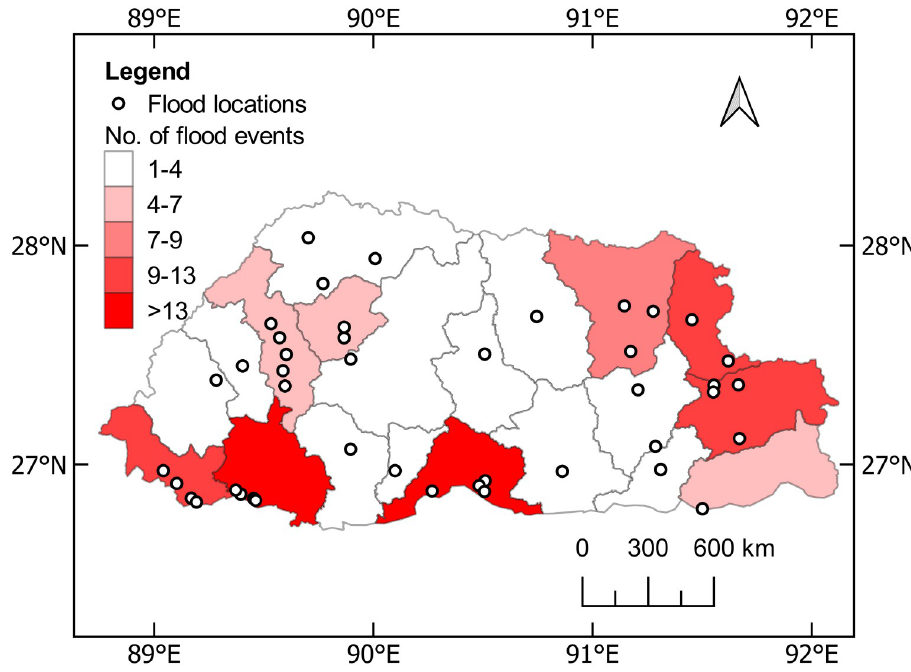
Fig 6. District-level flood hazard zonation of Bhutan and locations of the major flood